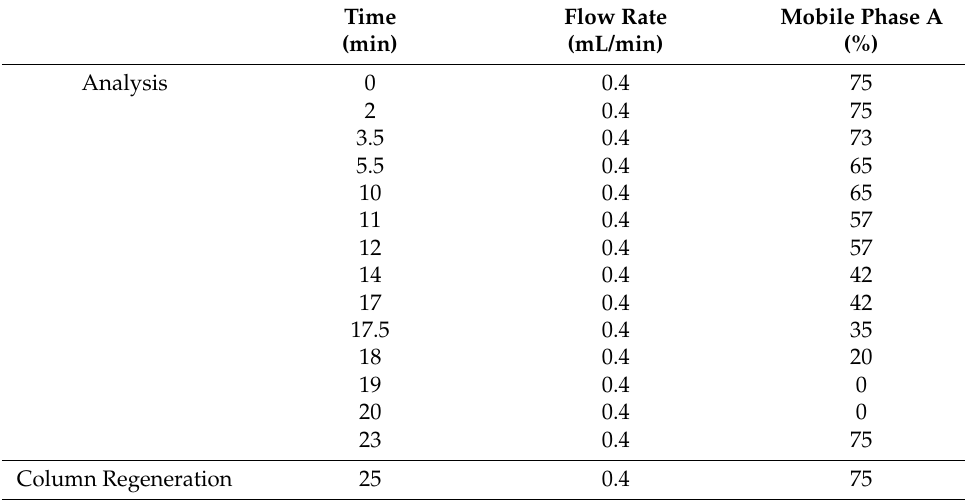
Table 7. LC-gradient conditions for center